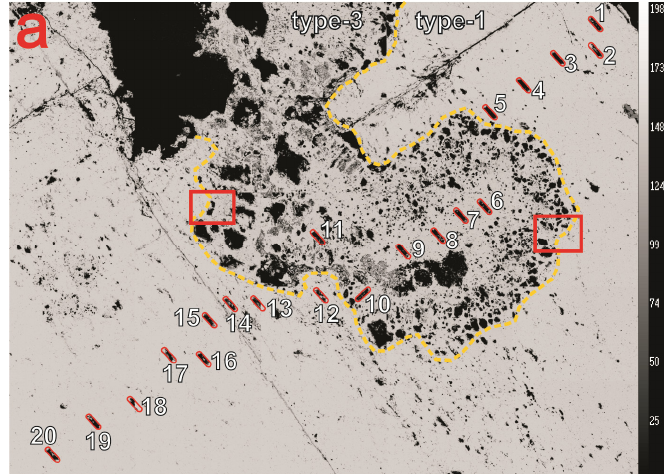
Figure 5. Backscatter electron images of the two polished sections 1 and 2 from the Bugarama deposit with laser ablation pits (red outlines). ( a ) Ablation pits 1–5 and 12–20 represent type-1 ferberite, whereas ablation pits 6–11 represent type-3 ferberite (yellow outline) in polished section 1. The two red-rimmed boxes indicate the areas of element mapping using electron microprobe (Figure 8). ( b ) Ablation pits 1–20 represent analyses of type-2 ferberite in polished section